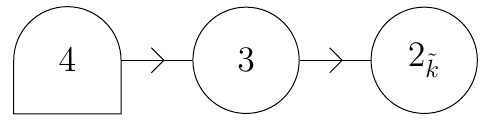
Figure 10 . The dual quiver diagram representing the defect SU(4)[1,1,2] with a CS term on the U(2)